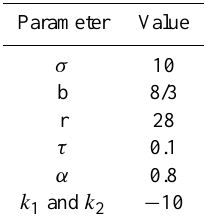
Table 1. Model parameters in Eq. (4) to Eq. (9).